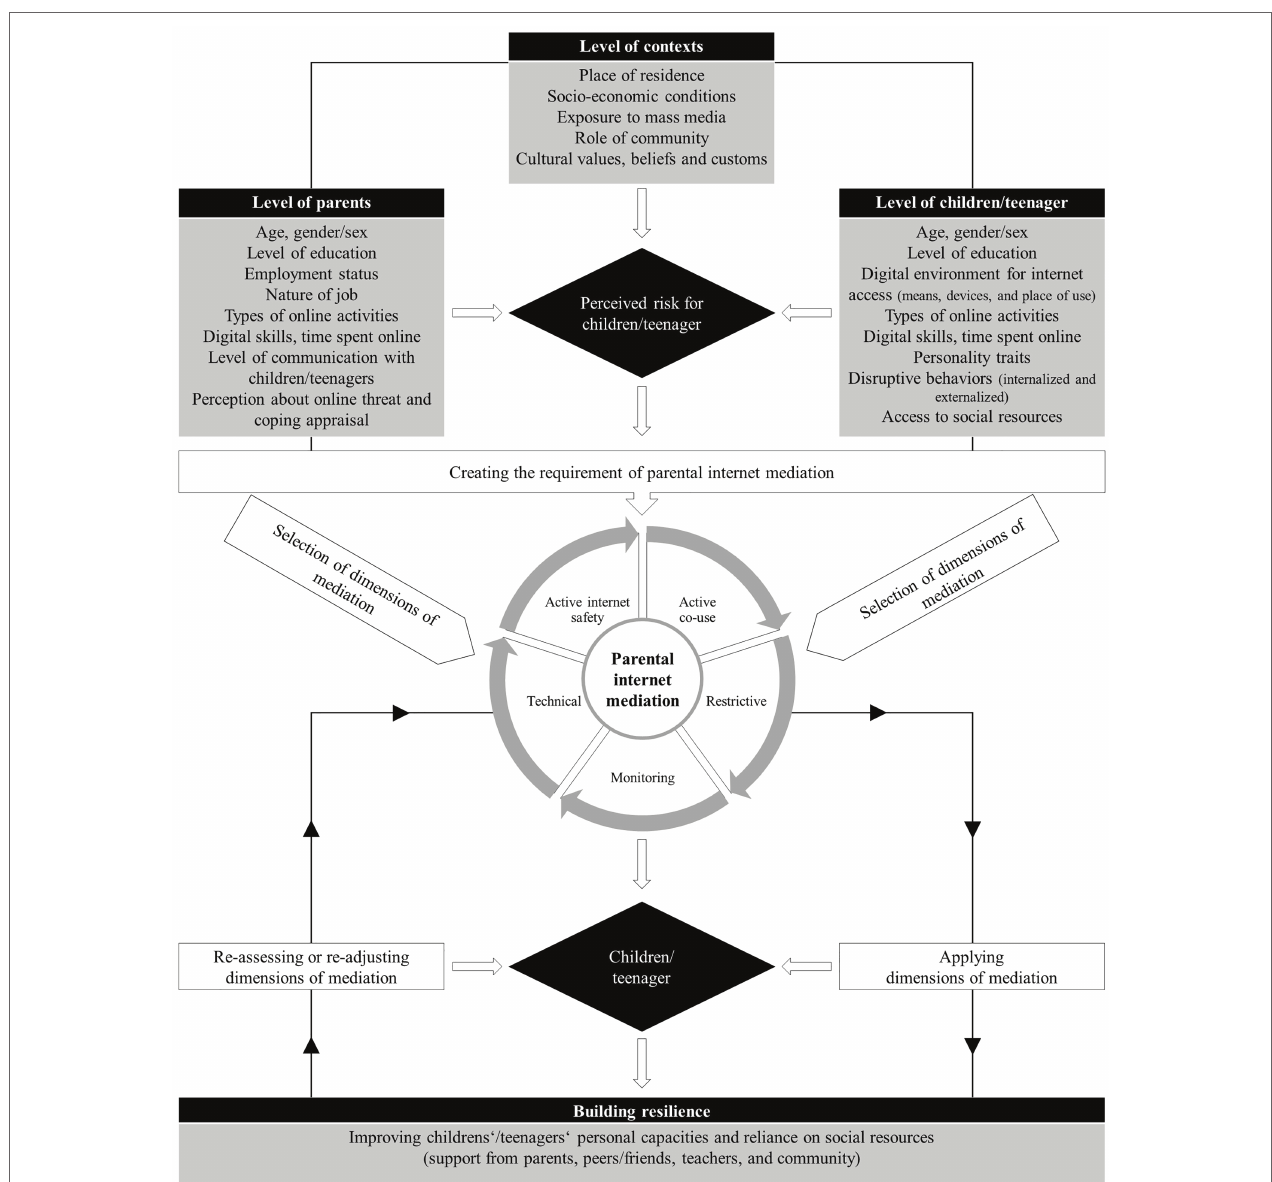
FIGURE 4 | Proposed theoretical framework for the predictors of parental internet